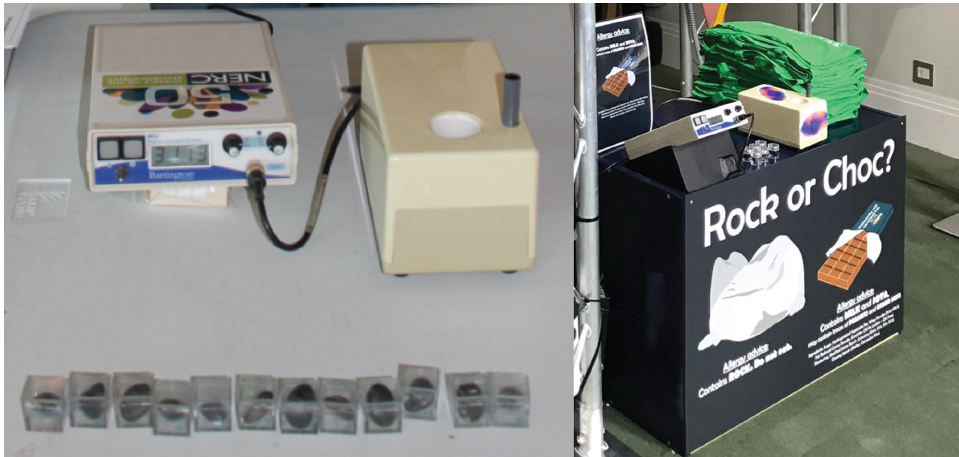
Figure 3. Rock or choc set-up, with boxes of chocolate and rock pebbles, and a Bartington susceptibility meter.